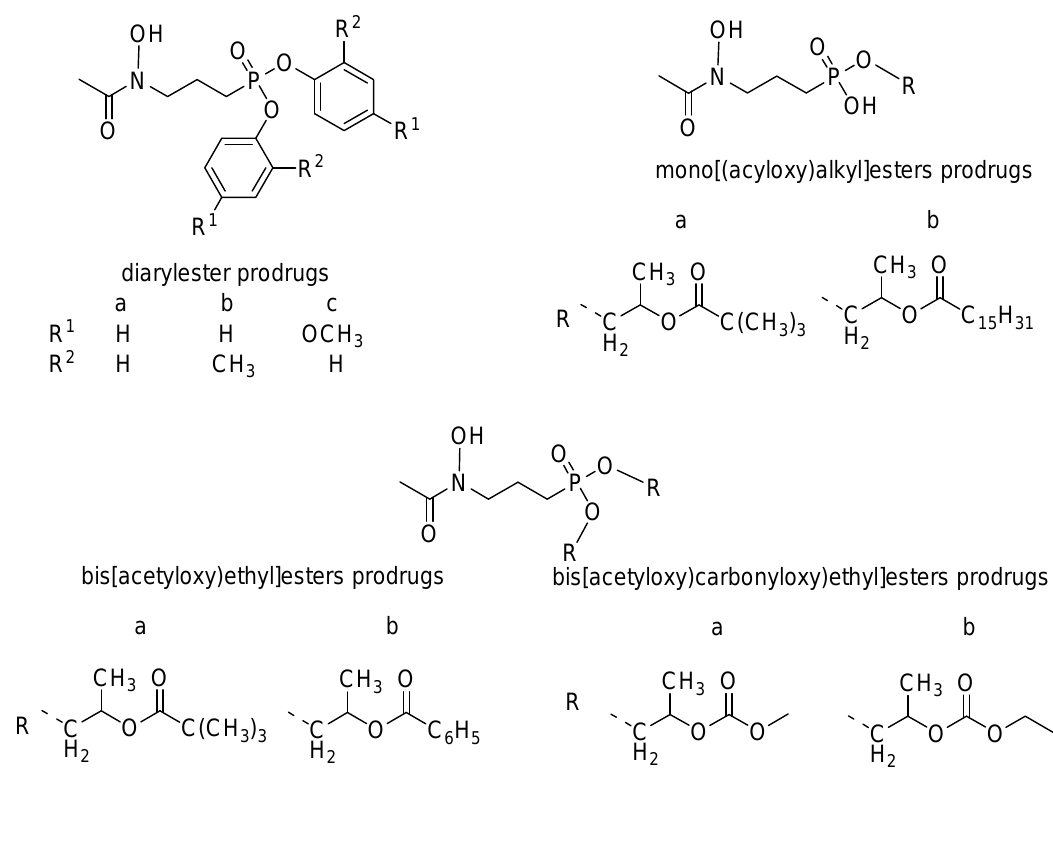
Figure 16. Chemical structures of FR900098 ester